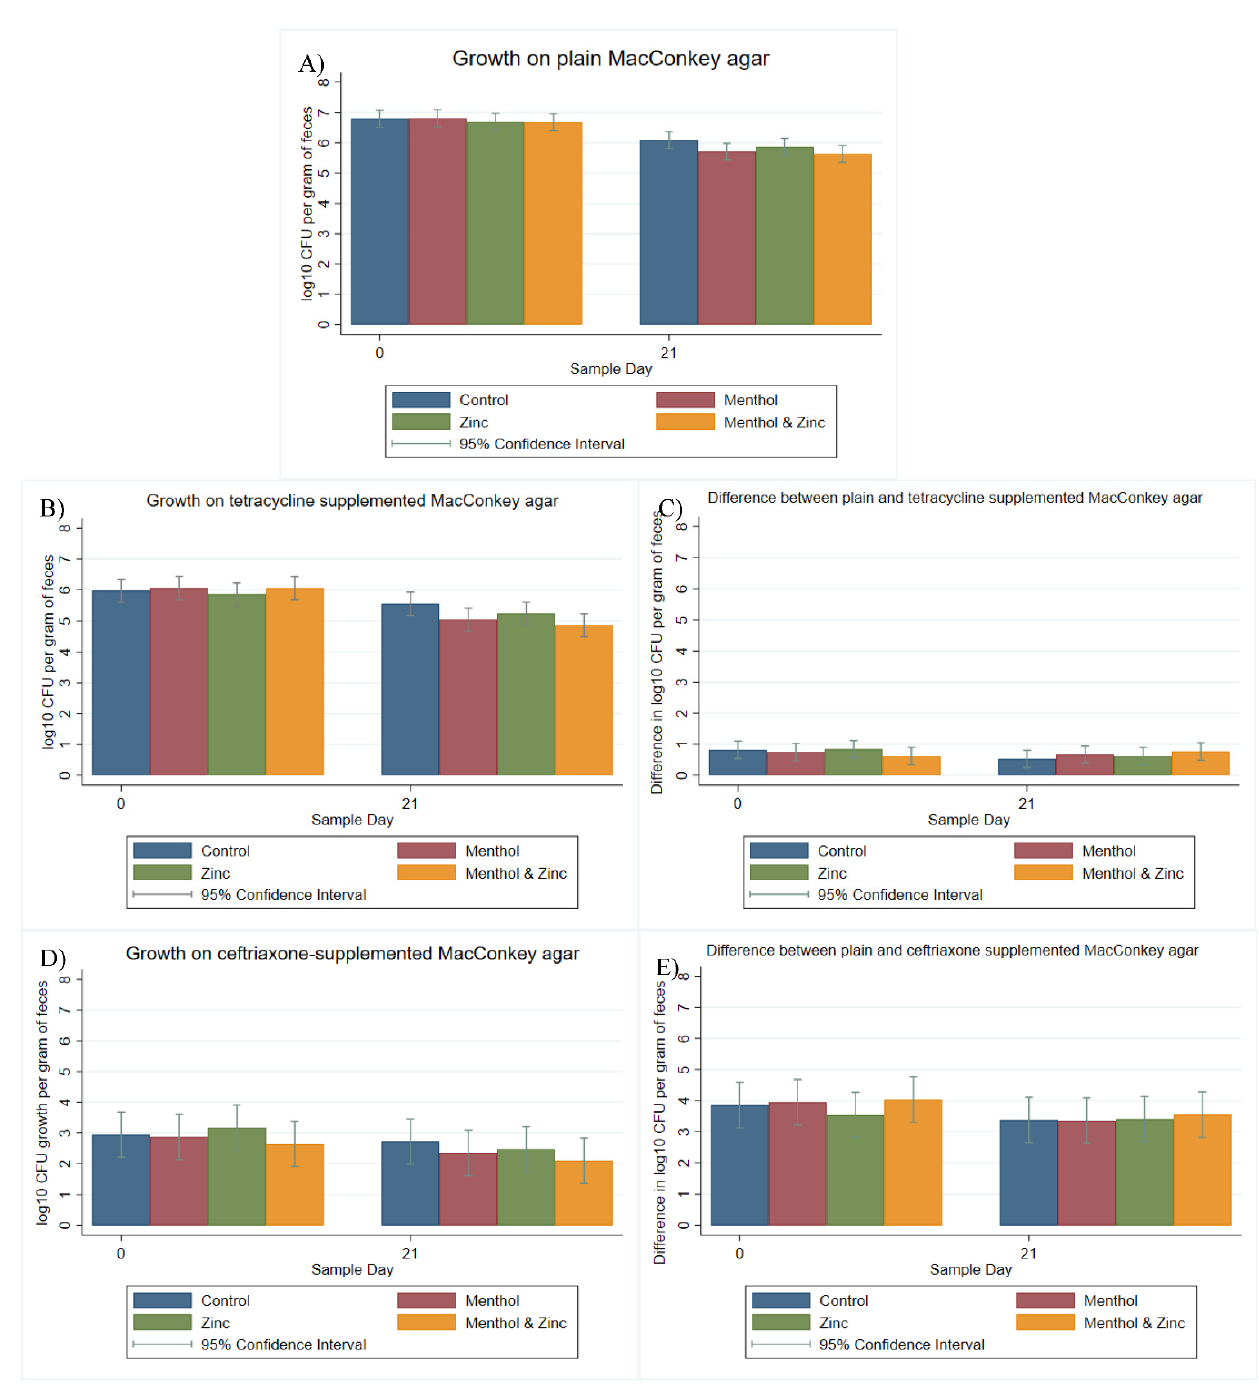
Figure 1. Marginal means with 95% confidence intervals of a 2 × 2 × 2 multi-level mixed linear regression model, using factors of zinc, menthol and sample day. ( A ) log 10 colony-forming units (CFU) per gram of feces on plain MacConkey agar, ( B ) log 10 CFU per gram of feces on tetracycline-supplemented (16 mg/L) MacConkey agar, ( C ) Difference in log 10 CFU between plain and tetracycline-supplemented (16 mg/L) MacConkey agar, ( D ) log 10 CFU per gram of feces on ceftriaxone-supplemented (4 mg/L) MacConkey agar and ( E ) Difference in log 10 CFU between plain and ceftriaxone supplemented (4 mg/L) MacConkey supplemented agar.